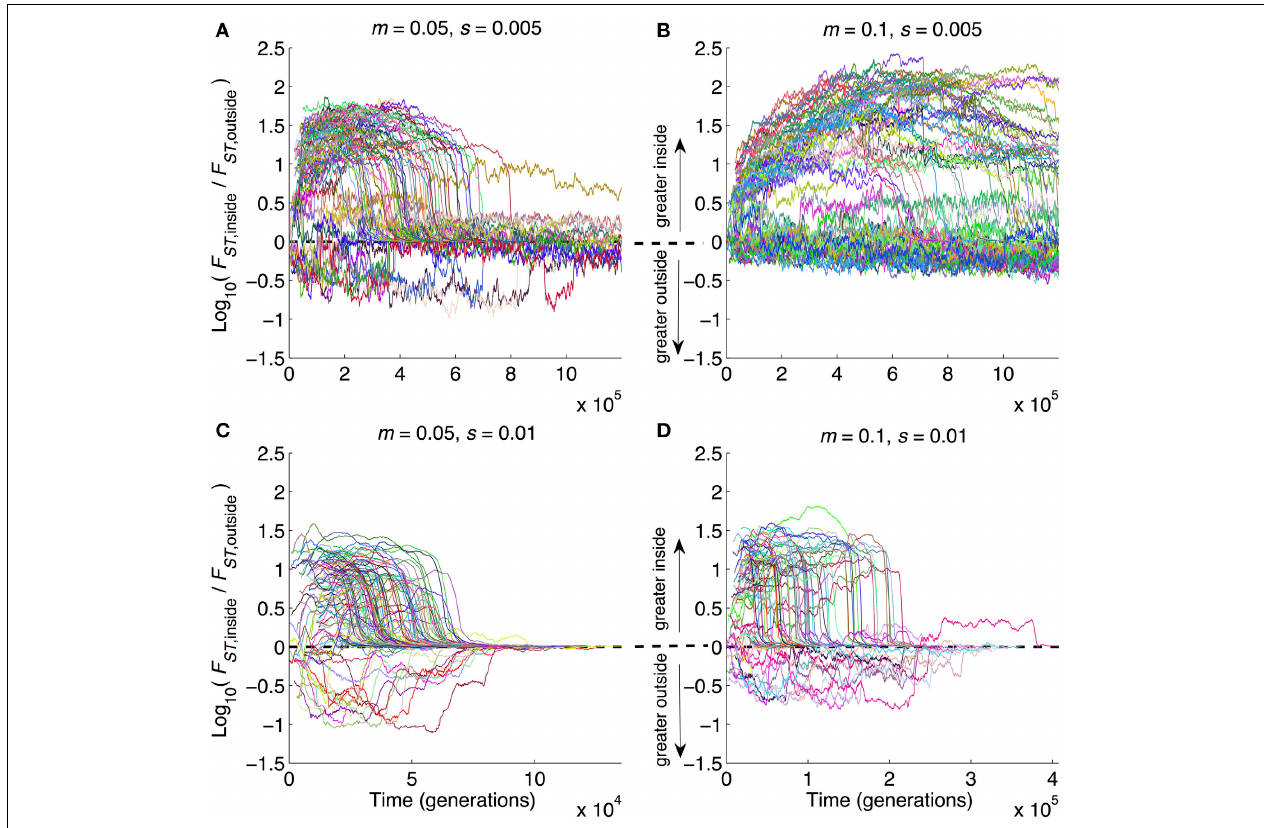
polymorphic sites inside inversions divided by mean F ST of polymorphic sites outside inversions. Note that the y-axes are Log 10 -transformed, and the x-axes vary in scaling from panel to panel in order to provide maximum visual resolution. Parameter combinations are the same as in Figure 2 : (A) m = 0 . 05, s = 0 . 005; (B) m = 0 . 1, s = 0 . 005, (C) m = 0 . 05, s = 0 . 01, (D) m = 0 . 1, s = 0 .